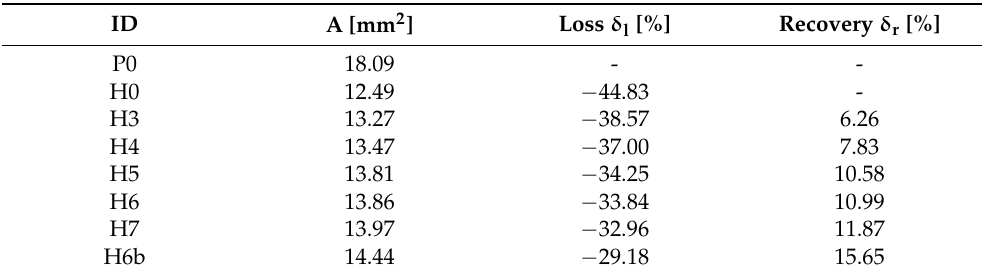
Table 2. Results of numerical simulations with different numbers and positions of holes in the fibrotic part.